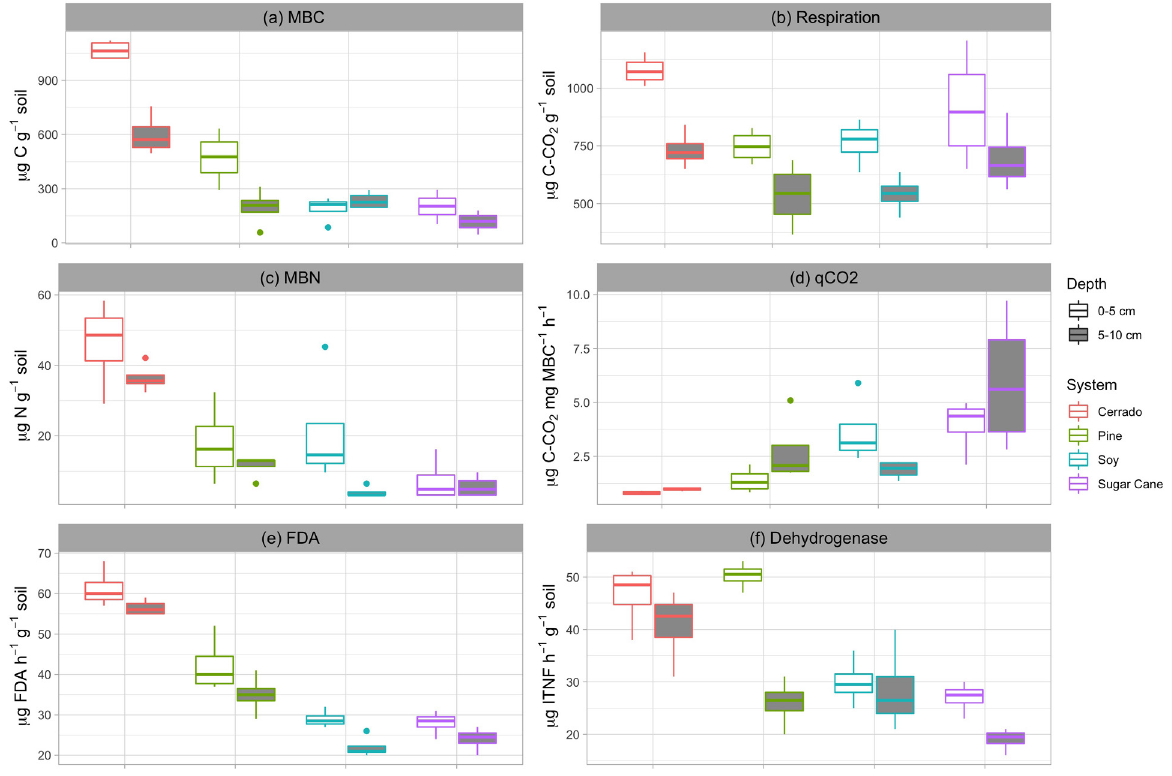
Figure 2 Soil microbial indicators in different land-uses and soil depths in the Brazilian Cerrado. (a), microbial biomass carbon (ug C g -1 soil dry); (b), soil microbial respiration (ug CO nitrogen (ug N g -1 soil dry); (d), metabolic coefficient (ug CO FDA g -1 soil h -1 ); (f), dehydrogenase activity (ug INTF g -1 soil h -1